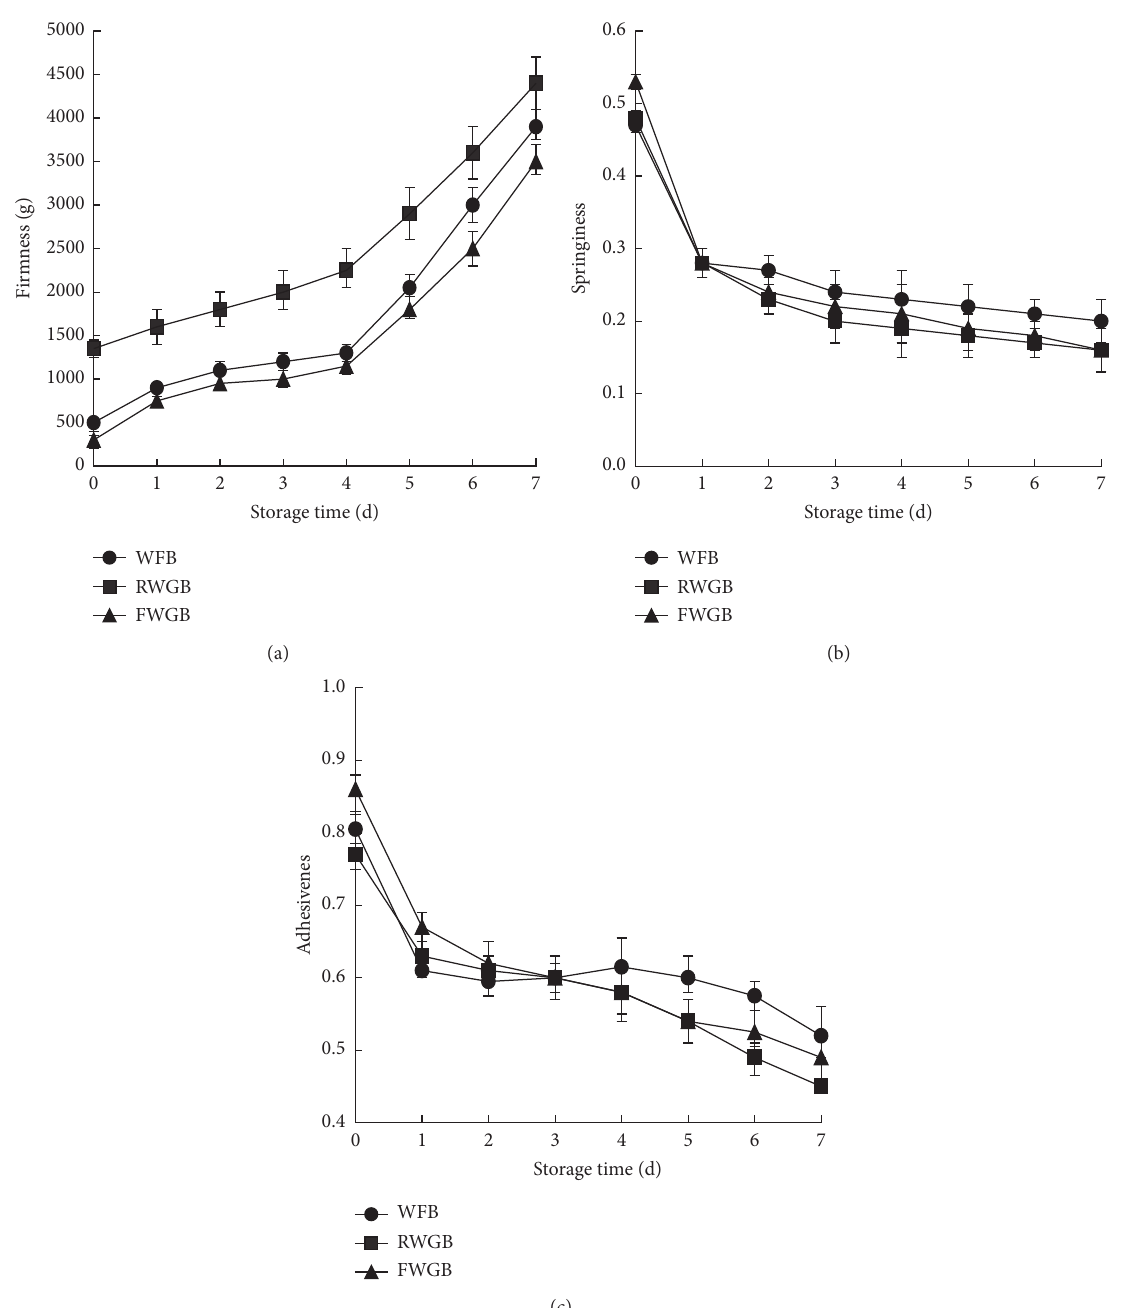
Figure 2: The texture properties (firmness, springiness, and adhesiveness) of bread during storage. WFB � wheat flour bread; RWGB � raw wheat germ bread; FWGB � fermented wheat germ bread. Values are the means ± standard deviations ( n �